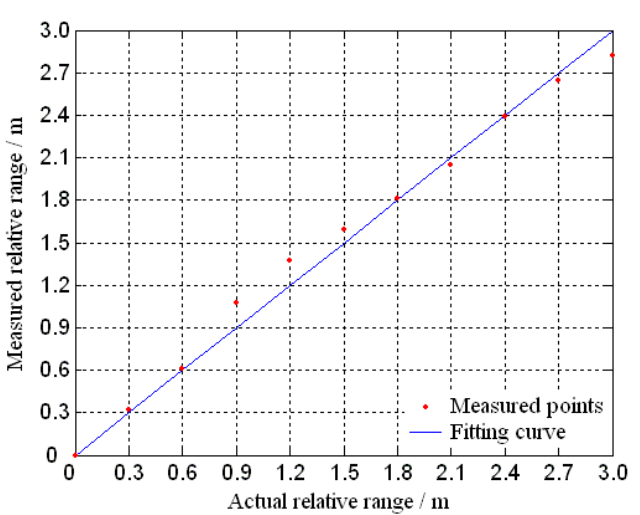
Figure 17. Relative range